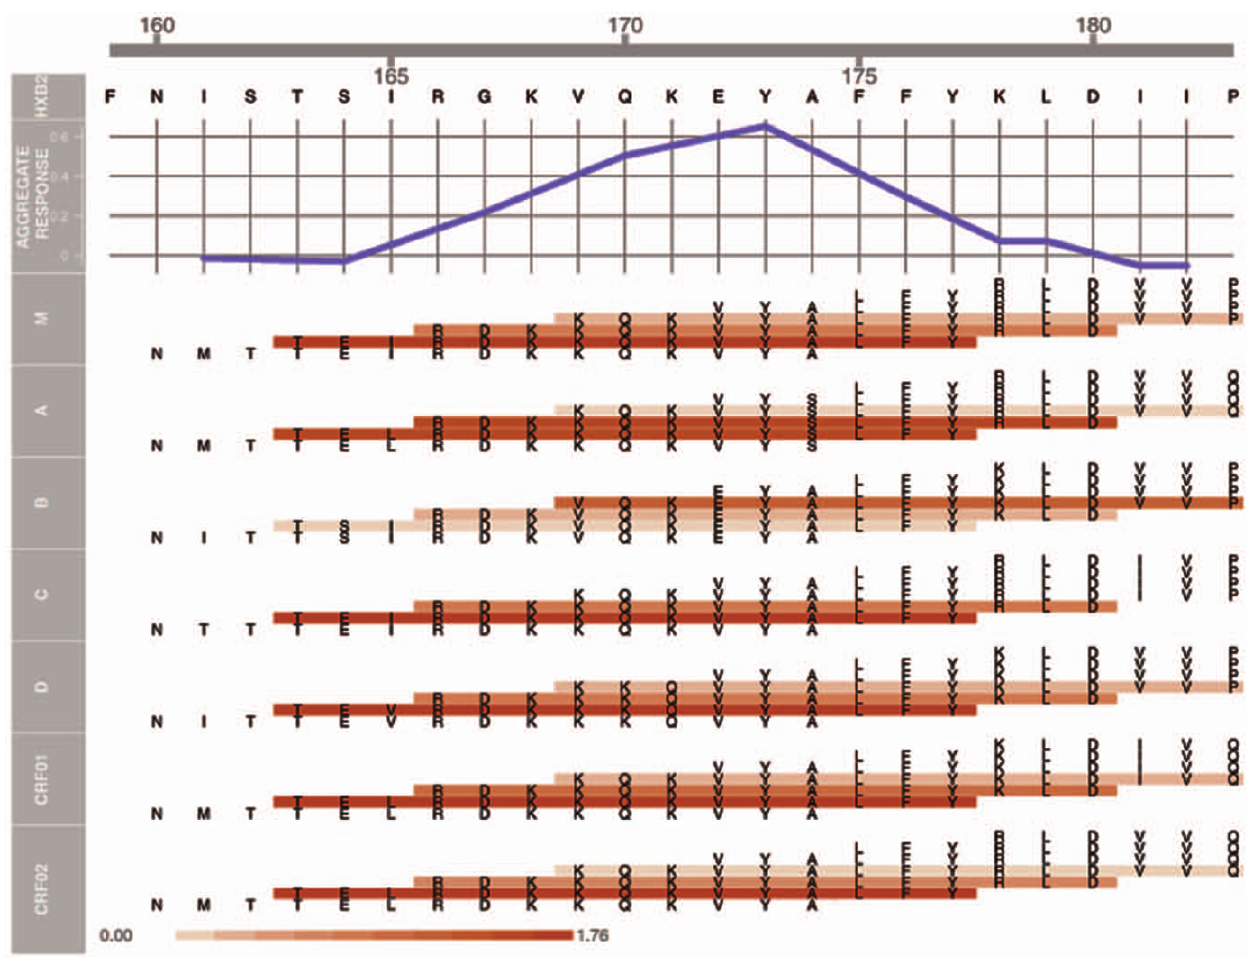
Figure 8. Hotspot analysis of the microarray data of V2 Abs in the plasma from vaccinees in the case-control study. The upper panel shows an aggregate response across all sub-types averaged across vaccinees as a function of the V2 sequence in subtype B strain HxB2. An individual aggregate response is computed using a sliding window mean statistic of 9 AAs, i.e., peptides with HxB2 positions of 9 contiguous AAs averaged together. In the lower portion of the figure, the actual sequence of each of the overlapping 15-mers spanning V2 positions 160–183 is shown. The seven sets of peptides represent the consensus V2 regions of HIV-1 Group M and of subtypes A, B, C, D, CRF01_AE and CRF02_AG. Peptides are colored according to their average response across all vaccinees, with a scale of 0 (white) to 1.76 (red). All responses are calculated using normalized intensities and by subtracting the intensities of baseline pre-bleeds.